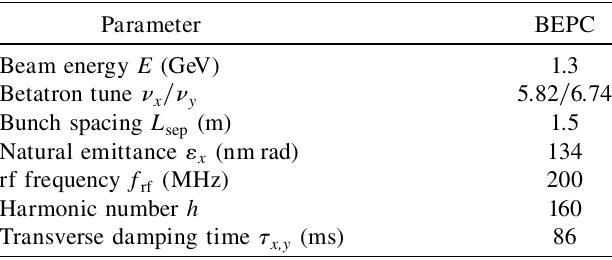
TABLE I. Parameters of the BEPC for